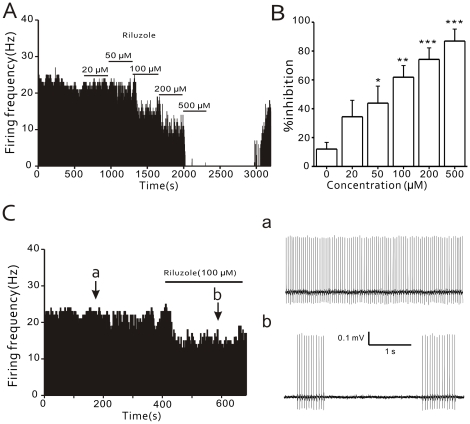
Effects of riluzole on the spontaneous activity of A-type neurons in the compressed DRG.(A) Time histogram showing that local application of the INaP blocker riluzole reduces the basal firing rate of an A-type fiber in a dose-dependent manner (n = 6; P<0.05). (B) Percent inhibition of spontaneous activity in A-type fibers with respect to the concentration of locally-applied riluzole (µM; n = 6; *P<0.05, **P<0.01, ***P<0.001). (C) Time histogram showing the suppression of spontaneous activity induced by riluzole (100 µM) in an A-type afferent fiber from a compressed DRG. Expanded traces in right panel show firing patterns before (a) and during (b) the drug application.